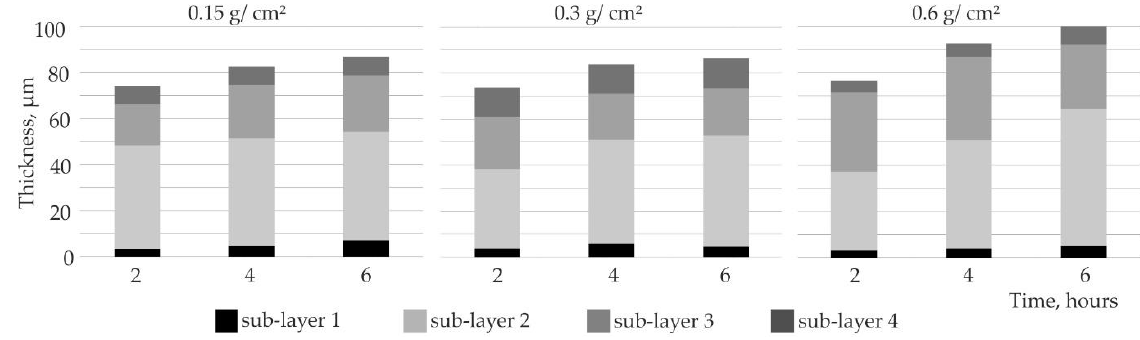
Figure 11. Thickness of Si-Al coatings obtained at 1000 °C for different slurry volume and after varied annealing times.